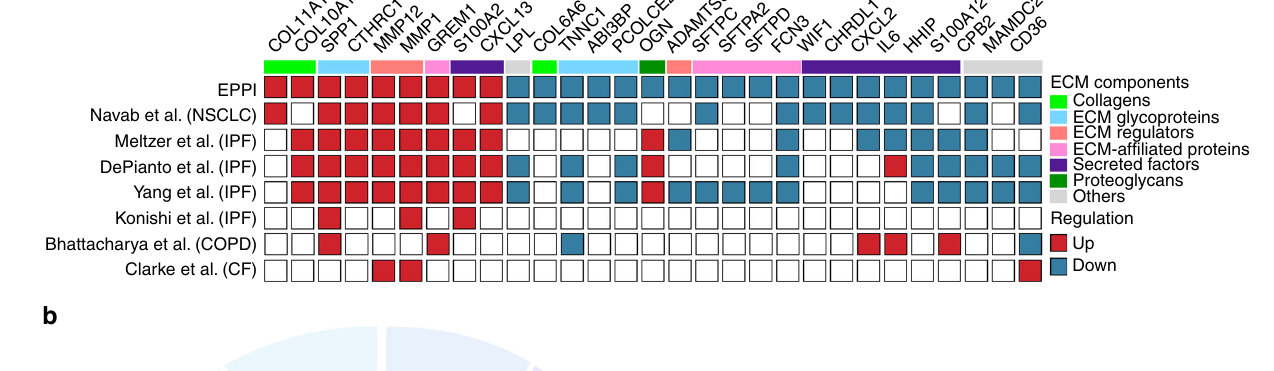
positive. The risk score generated for each patient in the discovery set was visua- lized with a personalized two-dimensional heatmap using Gene-E open software (Broad Institute).